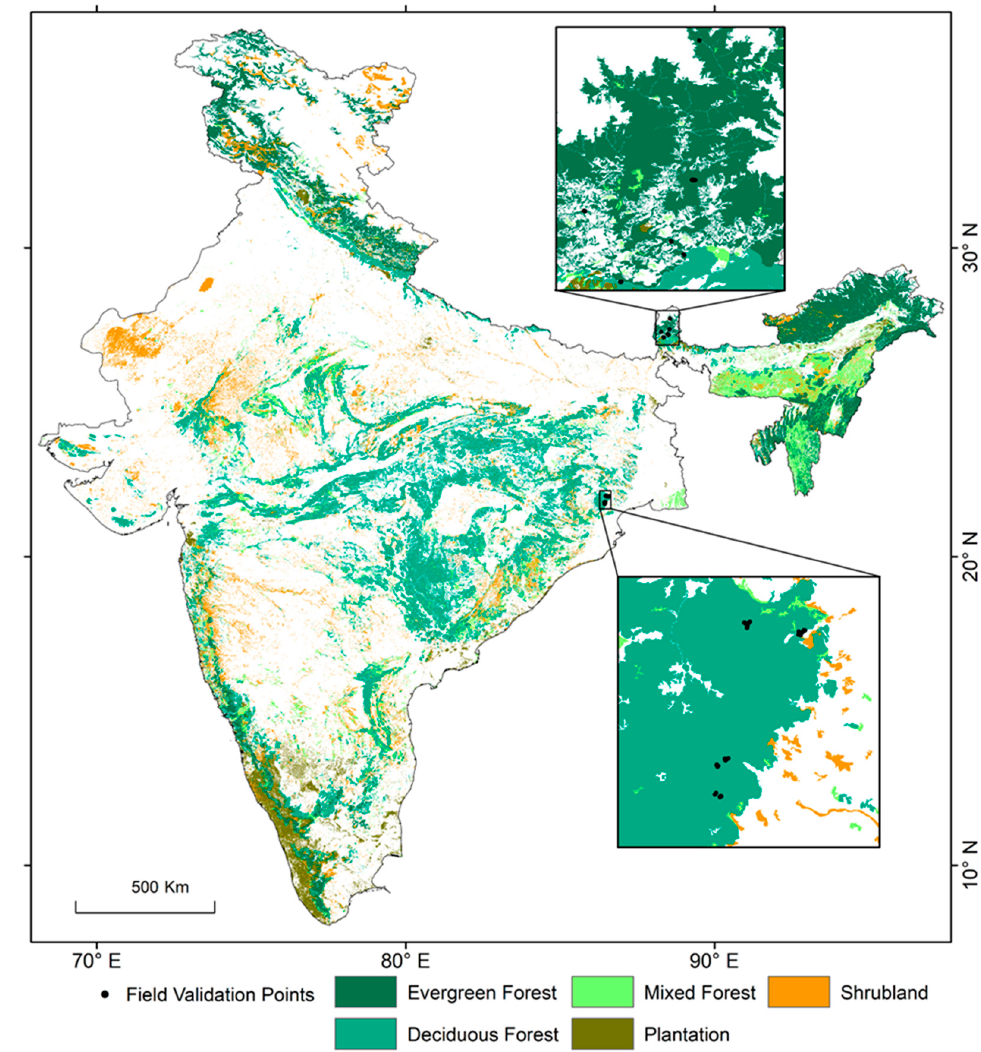
Figure 1. Study area. India land cover map (representing only the major forest covers).